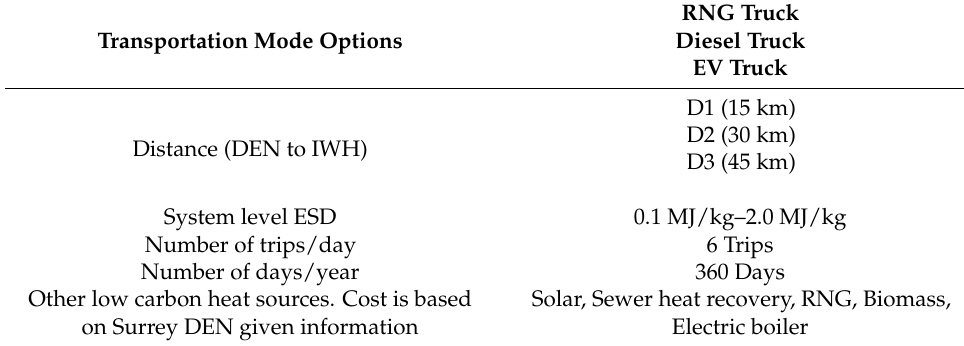
Table 2. Parameters used in creating comparison